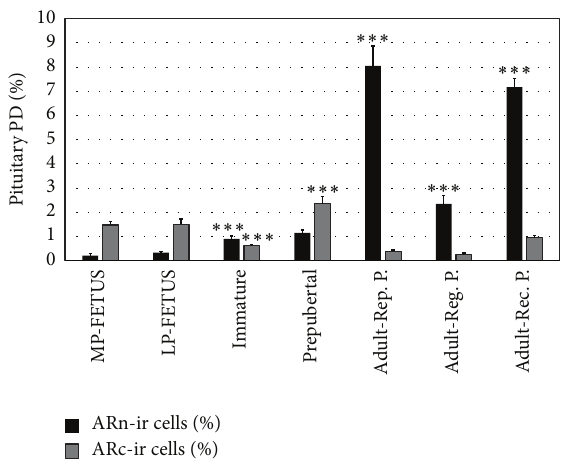
Figure 5: Total percentage of ARn-ir cells and ARc-ir cells in fetus (from mid- and late pregnancy), immature, prepubertal, and adult viscachas (during reproductive, gonadal regression, and gonadal recovery periods). The result revealed statistically signifi- cant changes: ∗∗∗ 𝑃 < 0.001 immature versus LP-FETUS; prepu- bertal versus immature; Adult-Rep. P. versus prepubertal; Adult- Reg. P. versus Adult-Rep. P.; Adult-Rec. P. versus Adult-Reg. P.